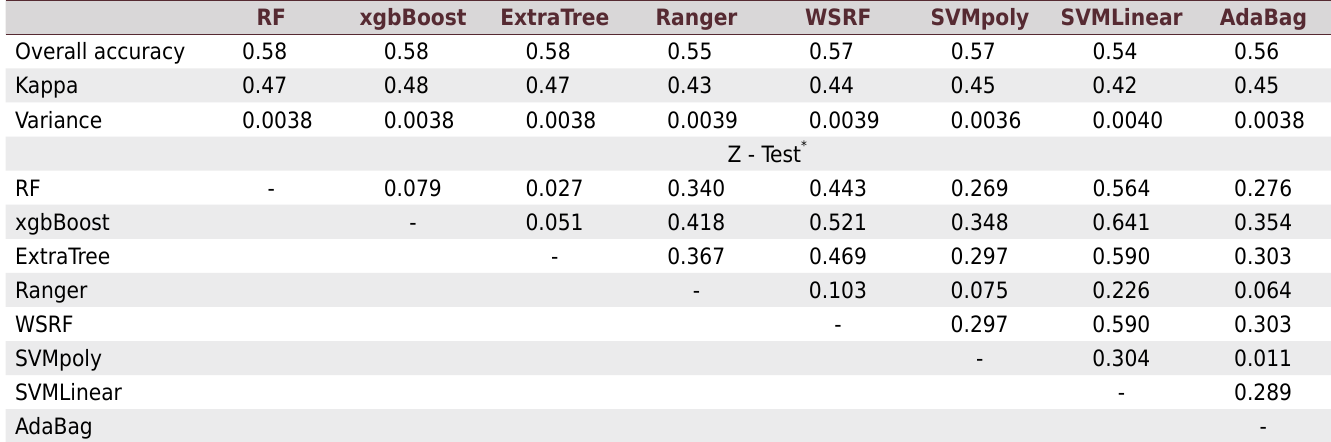
Table 4. Accuracy performance and the significance of Z-test for the kappa indexes of each classifier RF xgbBoost ExtraTree Ranger WSRF SVMpoly SVMLinear AdaBag Overall accuracy 0.58